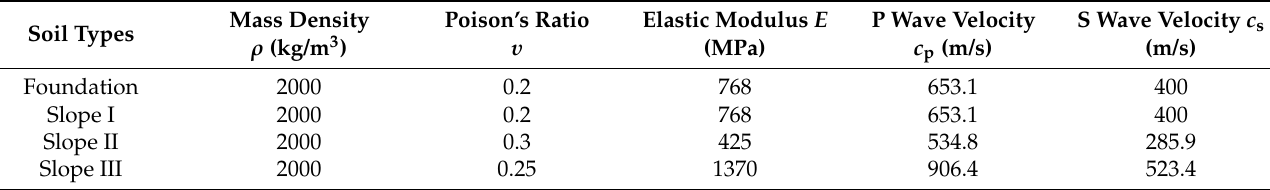
Table 1. Parameters of soil medium implemented in FEM.